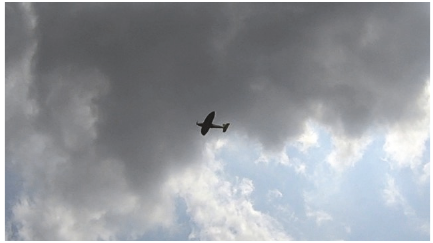
Figure 16: Flight test of the FMW